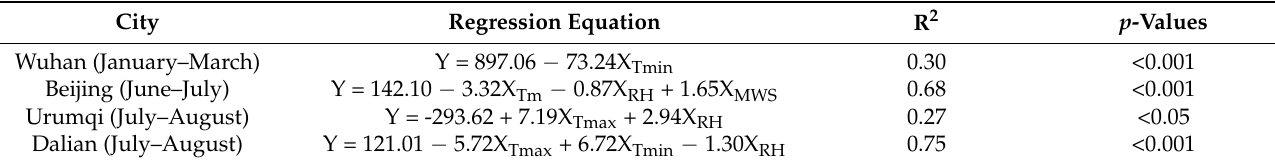
Table 4. The result of multiple stepwise regressions used to analyze the influence of meteorological factors on COVID-19 infected cases (Y) in four cities. City Regression Equation R 2 p